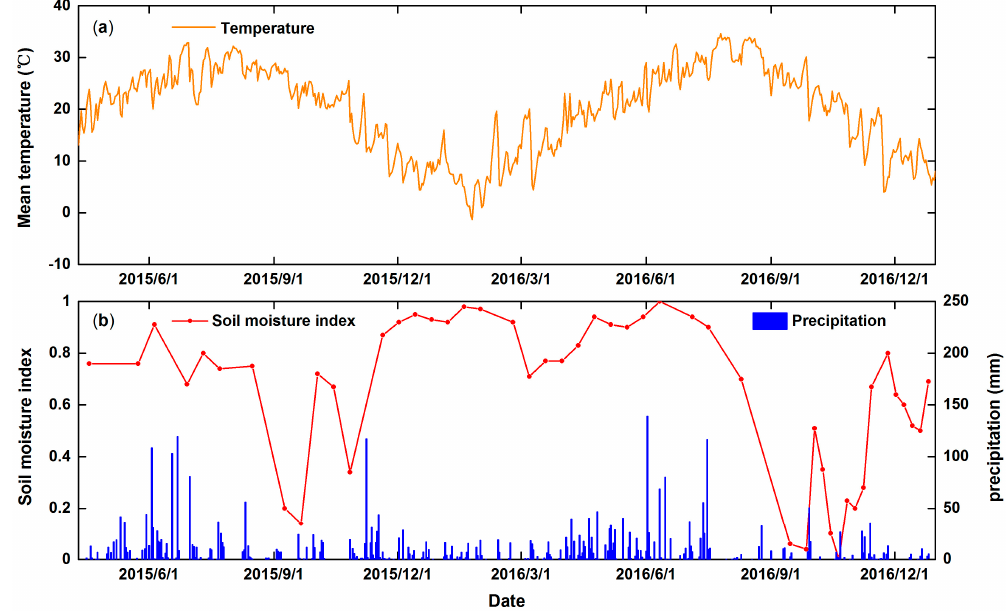
Figure 3. Time series of ( a ) daily mean temperature and ( b ) daily accumulated precipitation and measured soil moisture index over Nanchang site (115.9°E, 28.6°N) for the period from April 2015 to December 2016.